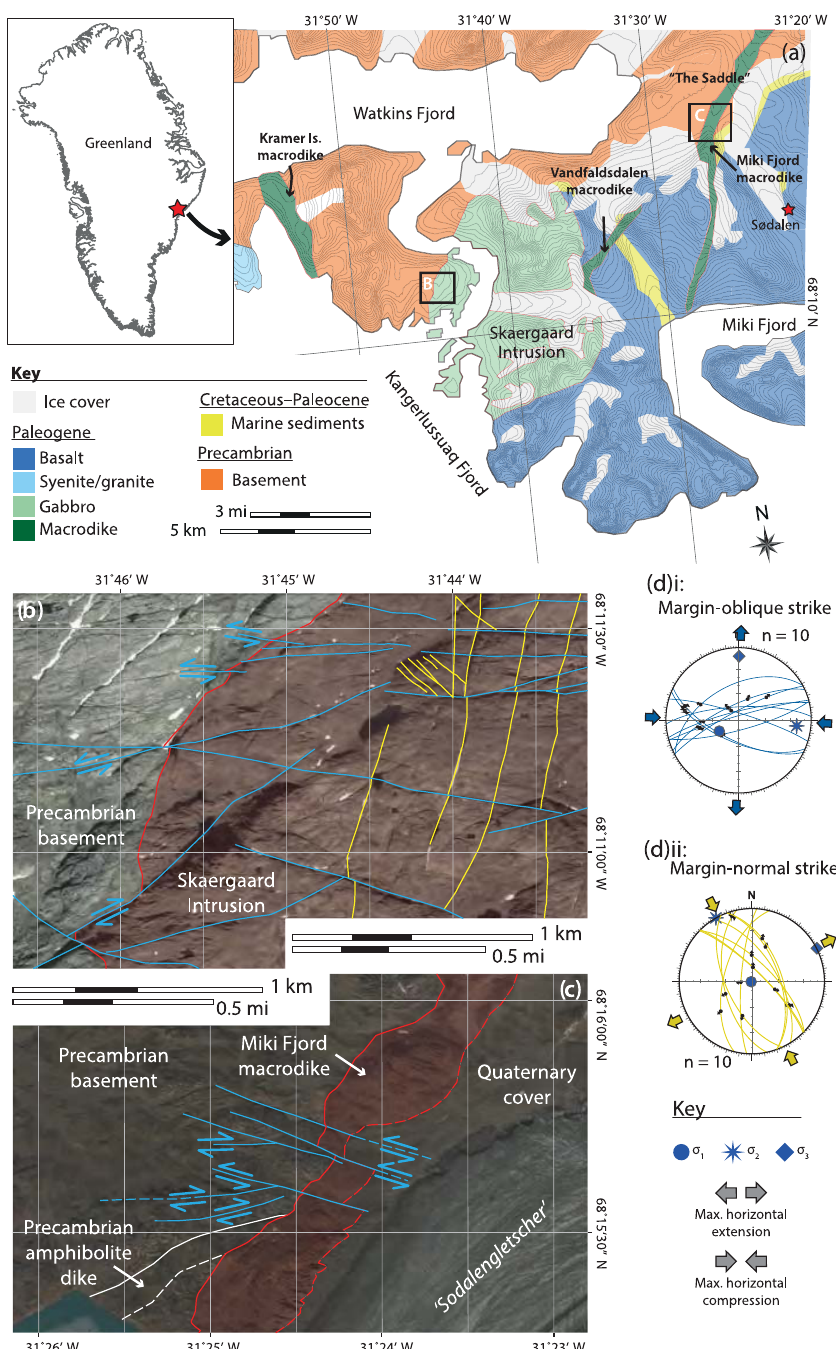
Figure 8. (a) Geological map of the Skaergaard intrusion and surrounding area (redrawn from Holwell et al., 2012). Contours indicate 50m elevation intervals from sea level. (b) Margin-normal-striking faults and dikes, which are in turn cut by margin-oblique-striking faults and dikes, cut the Skaergaard intrusion. (c) Margin-oblique-striking faults cut the margin-parallel Miki Fjord macrodike. (d) Lower-hemisphere stereographic projections for relative-age-constrained examples of the three main fault sets